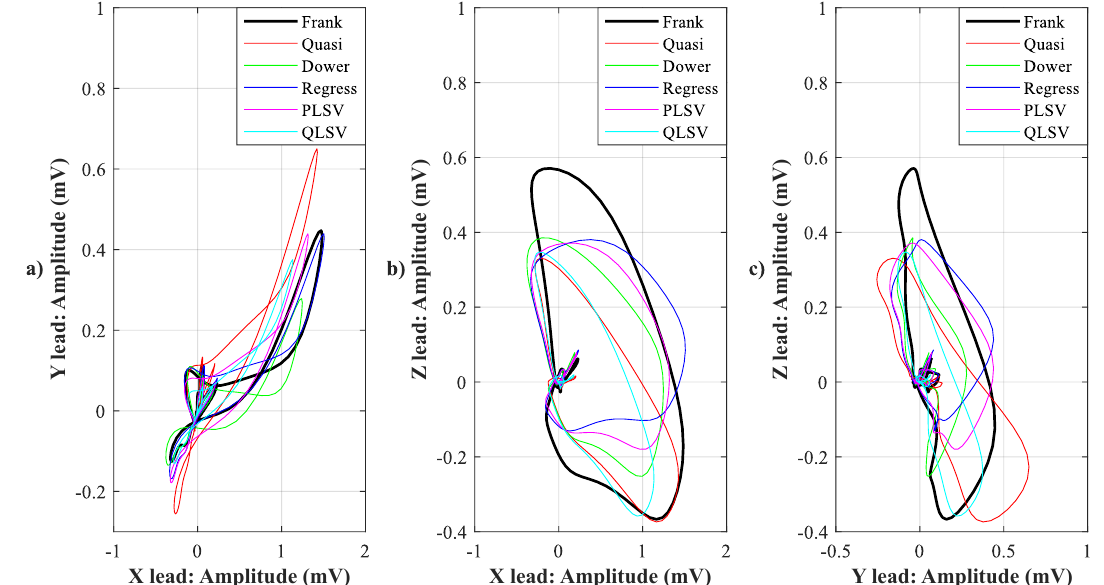
Figure 13. Comparison of transformation methods in 2-D, random patient 4. ( a ) X lead to Y lead, ( b ) X lead to Z lead, and ( c ) Y lead to Z lead.